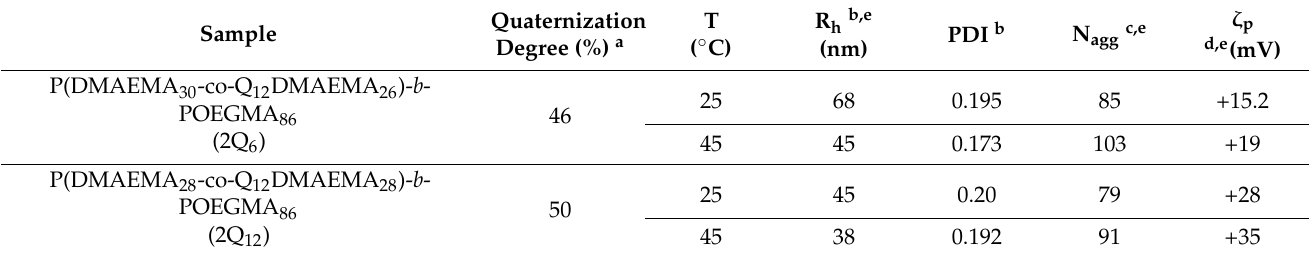
Table 5. Physicochemical characteristics of the P(DMAEMA 30 -co-Q 6 DMAEMA 26 )- b -POEGMA 86 and P(DMAEMA 28 - co-Q 12 DMAEMA 28 )- b -POEGMA 86 diblocks at two temperatures in solutions prepared by the organic solvent protocol (c = 1 × 10 − 3 g/mL).